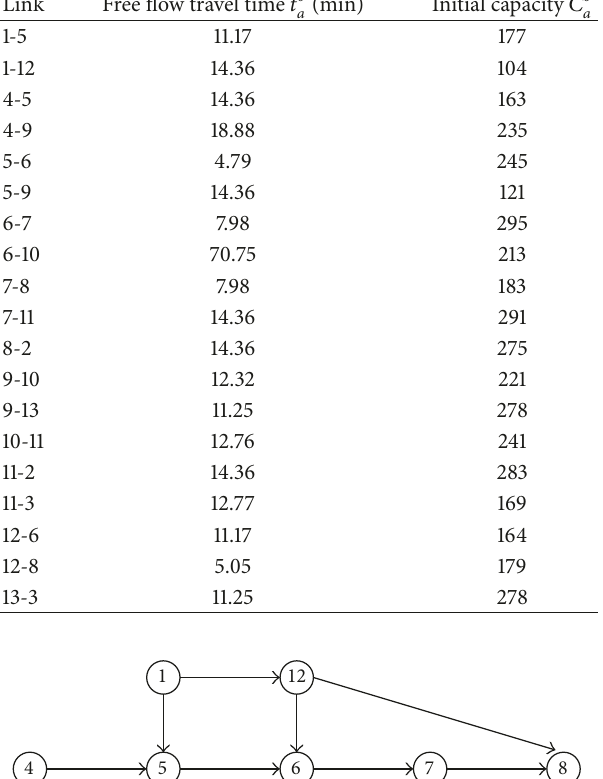
Table 1: Link characteristics of the Nguyen-Dupuis network.